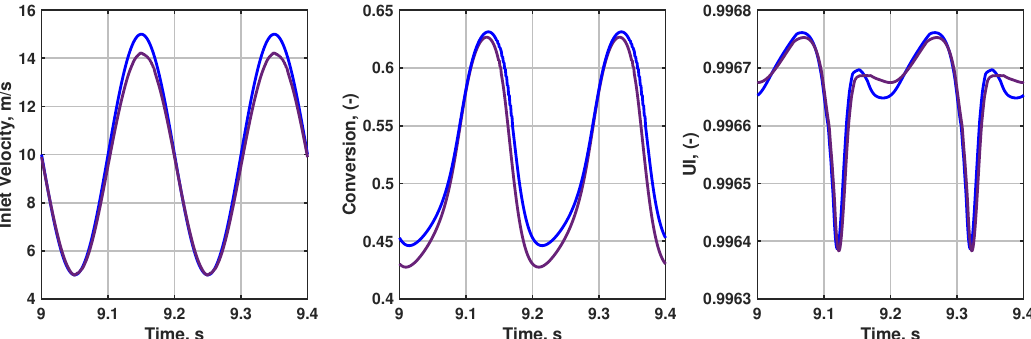
Figure 10. Resulting inlet velocity profiles ( left ), conversion at the system outlet ( middle ) and uniformity index of the reactant field ( right ) over time as obtained in cases 3 (blue) and 3B (purple).